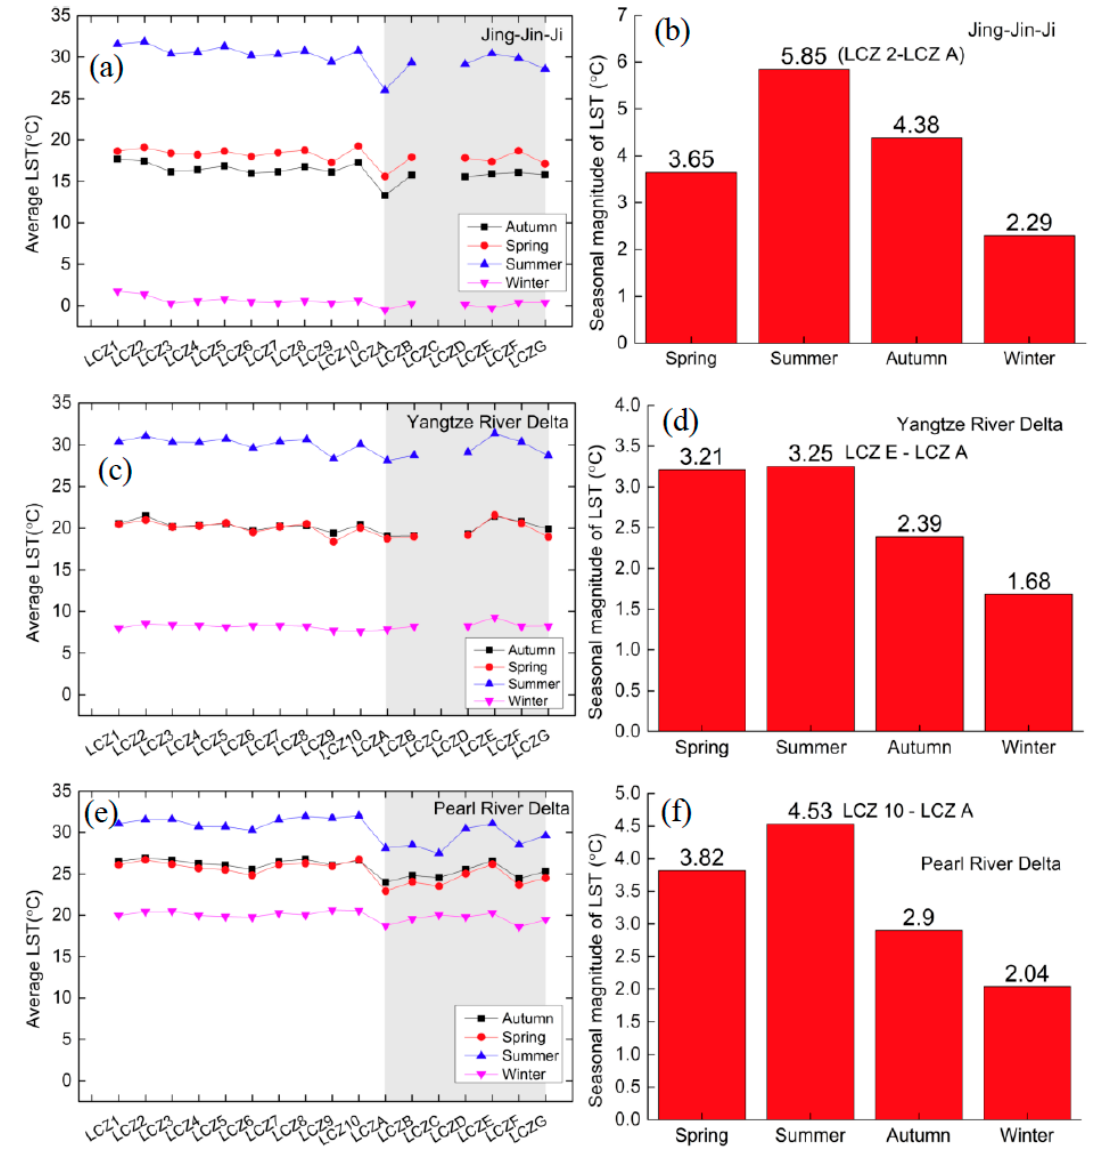
Figure 4. Seasonal mean LST of each LCZ type in JJJ, YRD and PRD ( a , c , e ), and the seasonal LST difference between maximum and minimum LSTs in the three urban agglomerations ( b , d , f ).